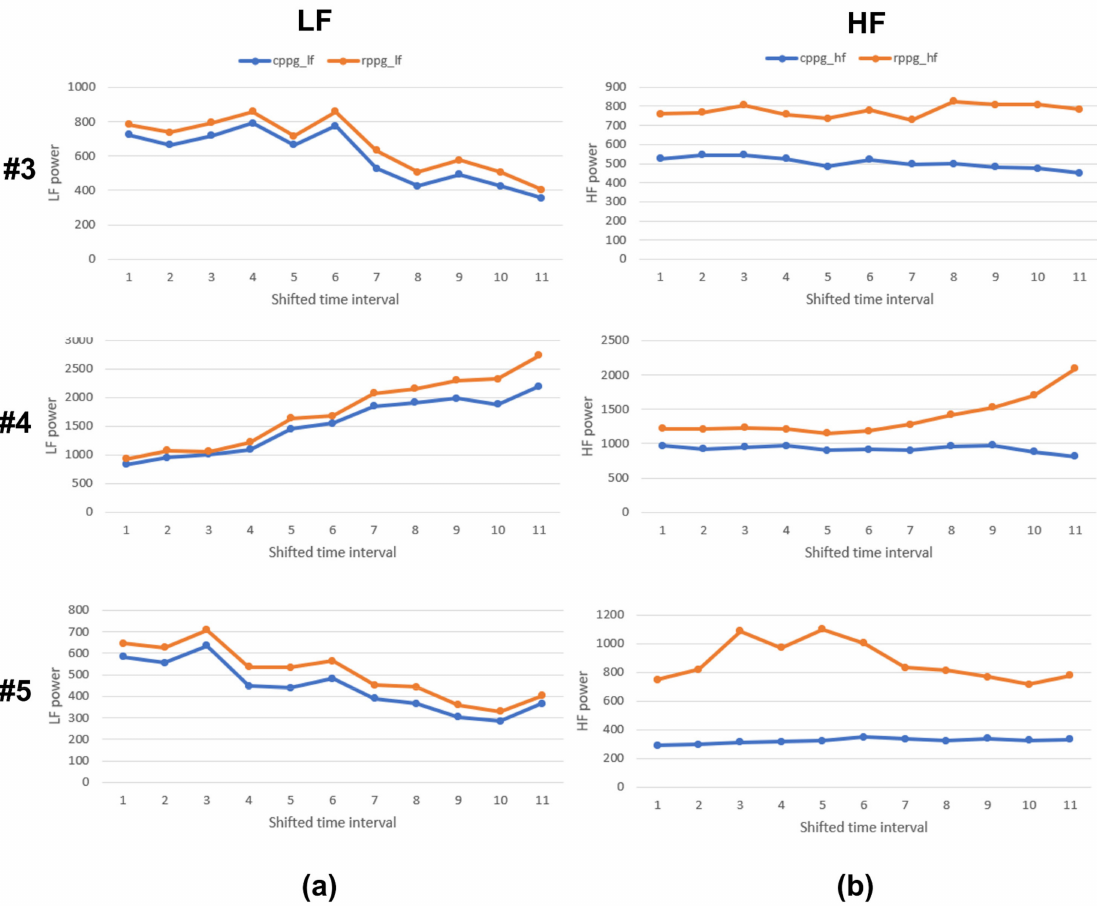
Figure 7. LF and HF graphs of subjects 3, 4, and 5. ( a ) LF, ( b )